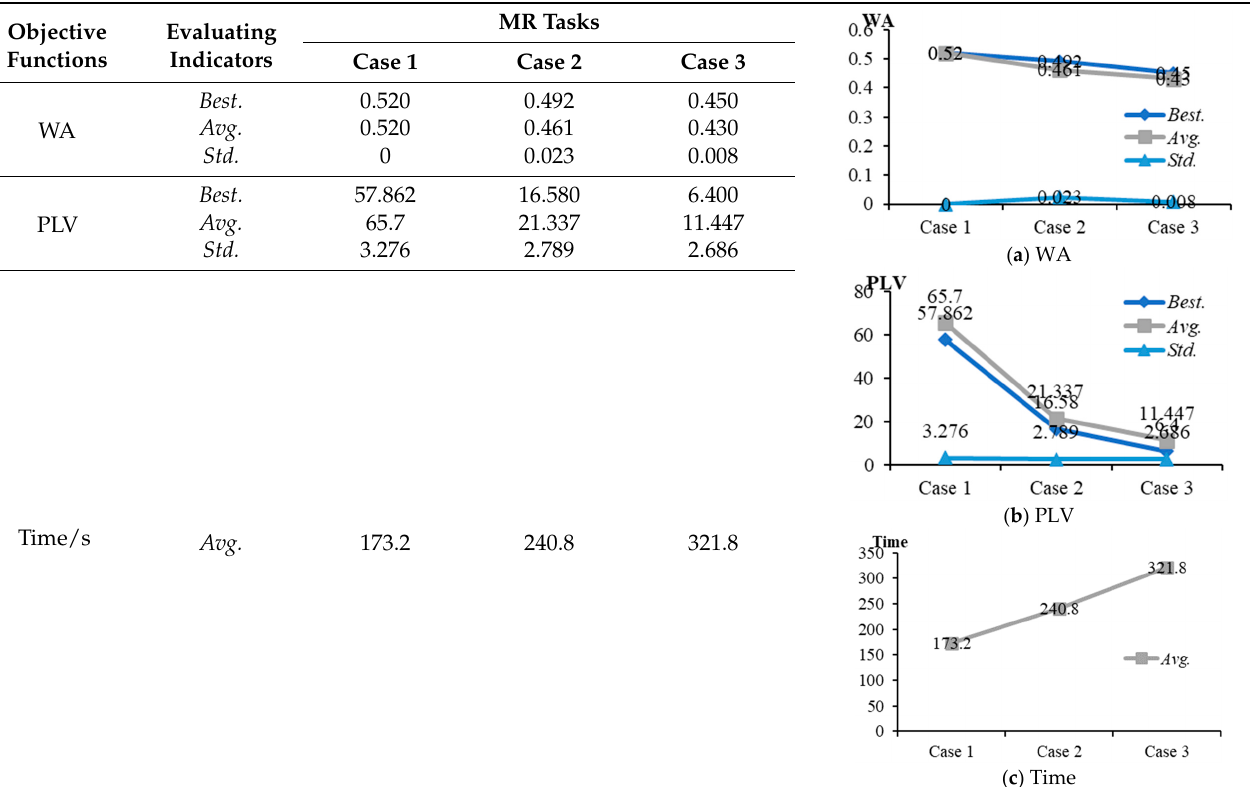
Table 6. Statistics of high-intensity task simulation